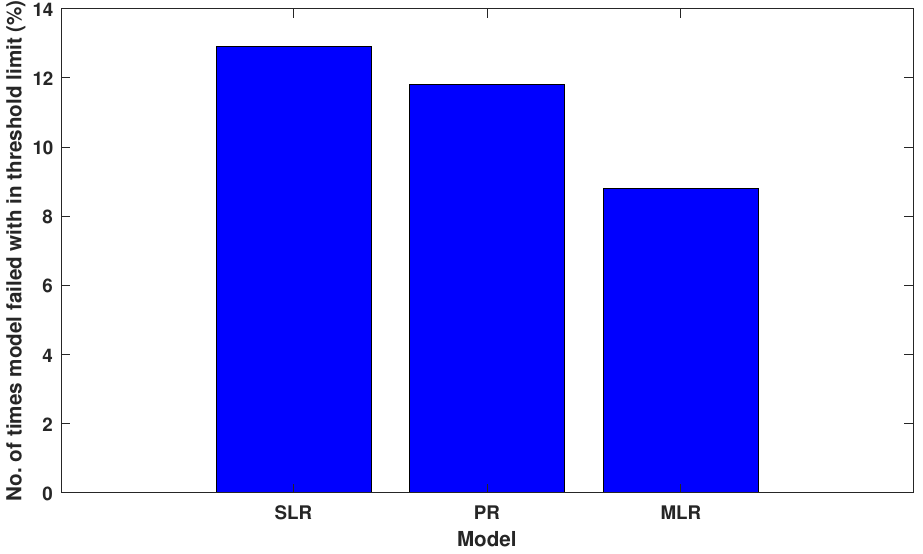
Figure 21. Model performance to predict load with in threshold limit.